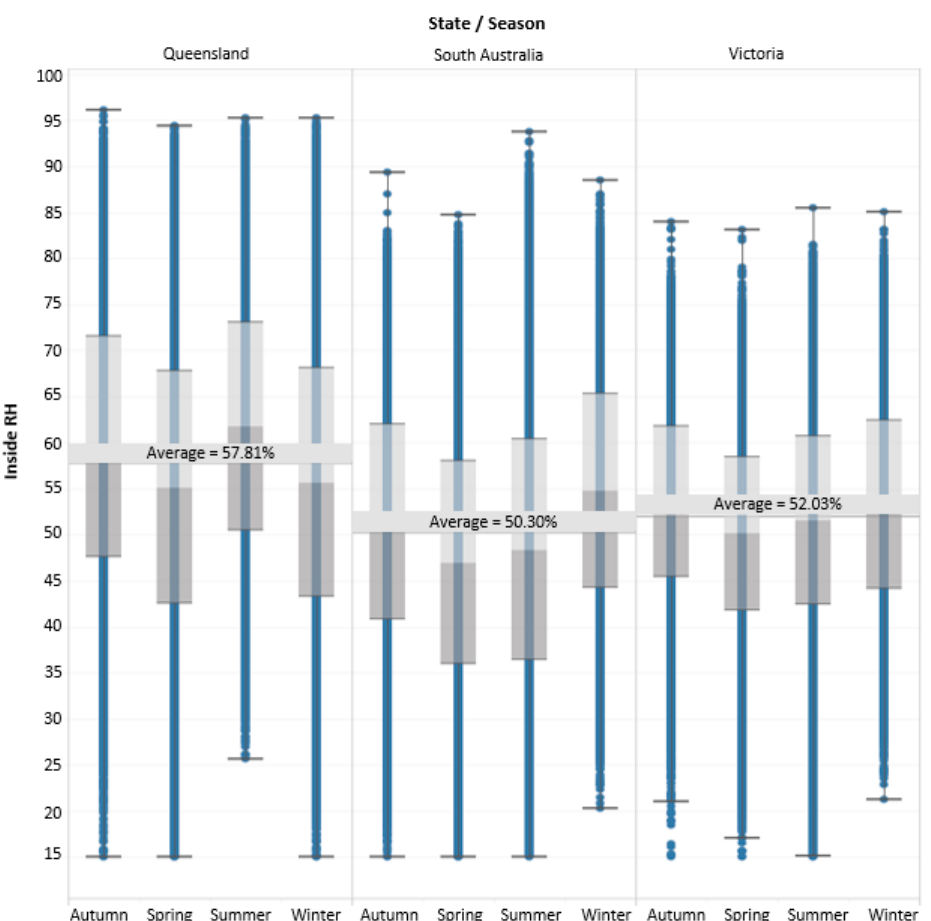
Figure 2. Indoor relative humidity in different seasons of Australian states [23].